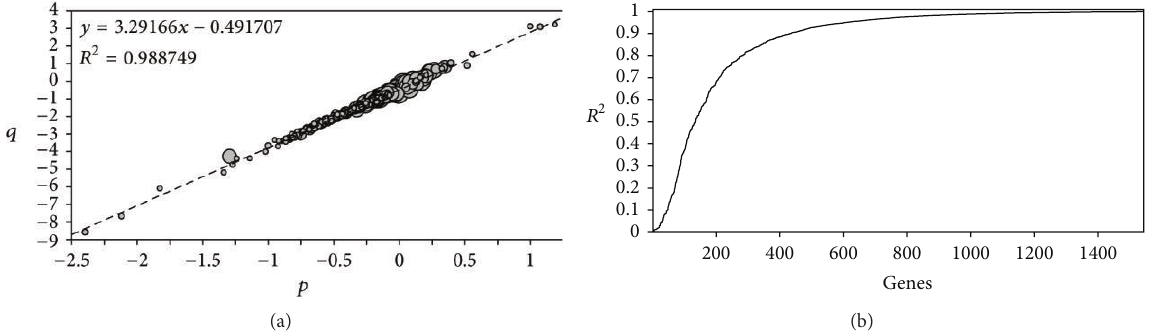
goodness of fit values for the PL regression of 40 genes from 27204 2-tuple HSRFs in Dataset 1.